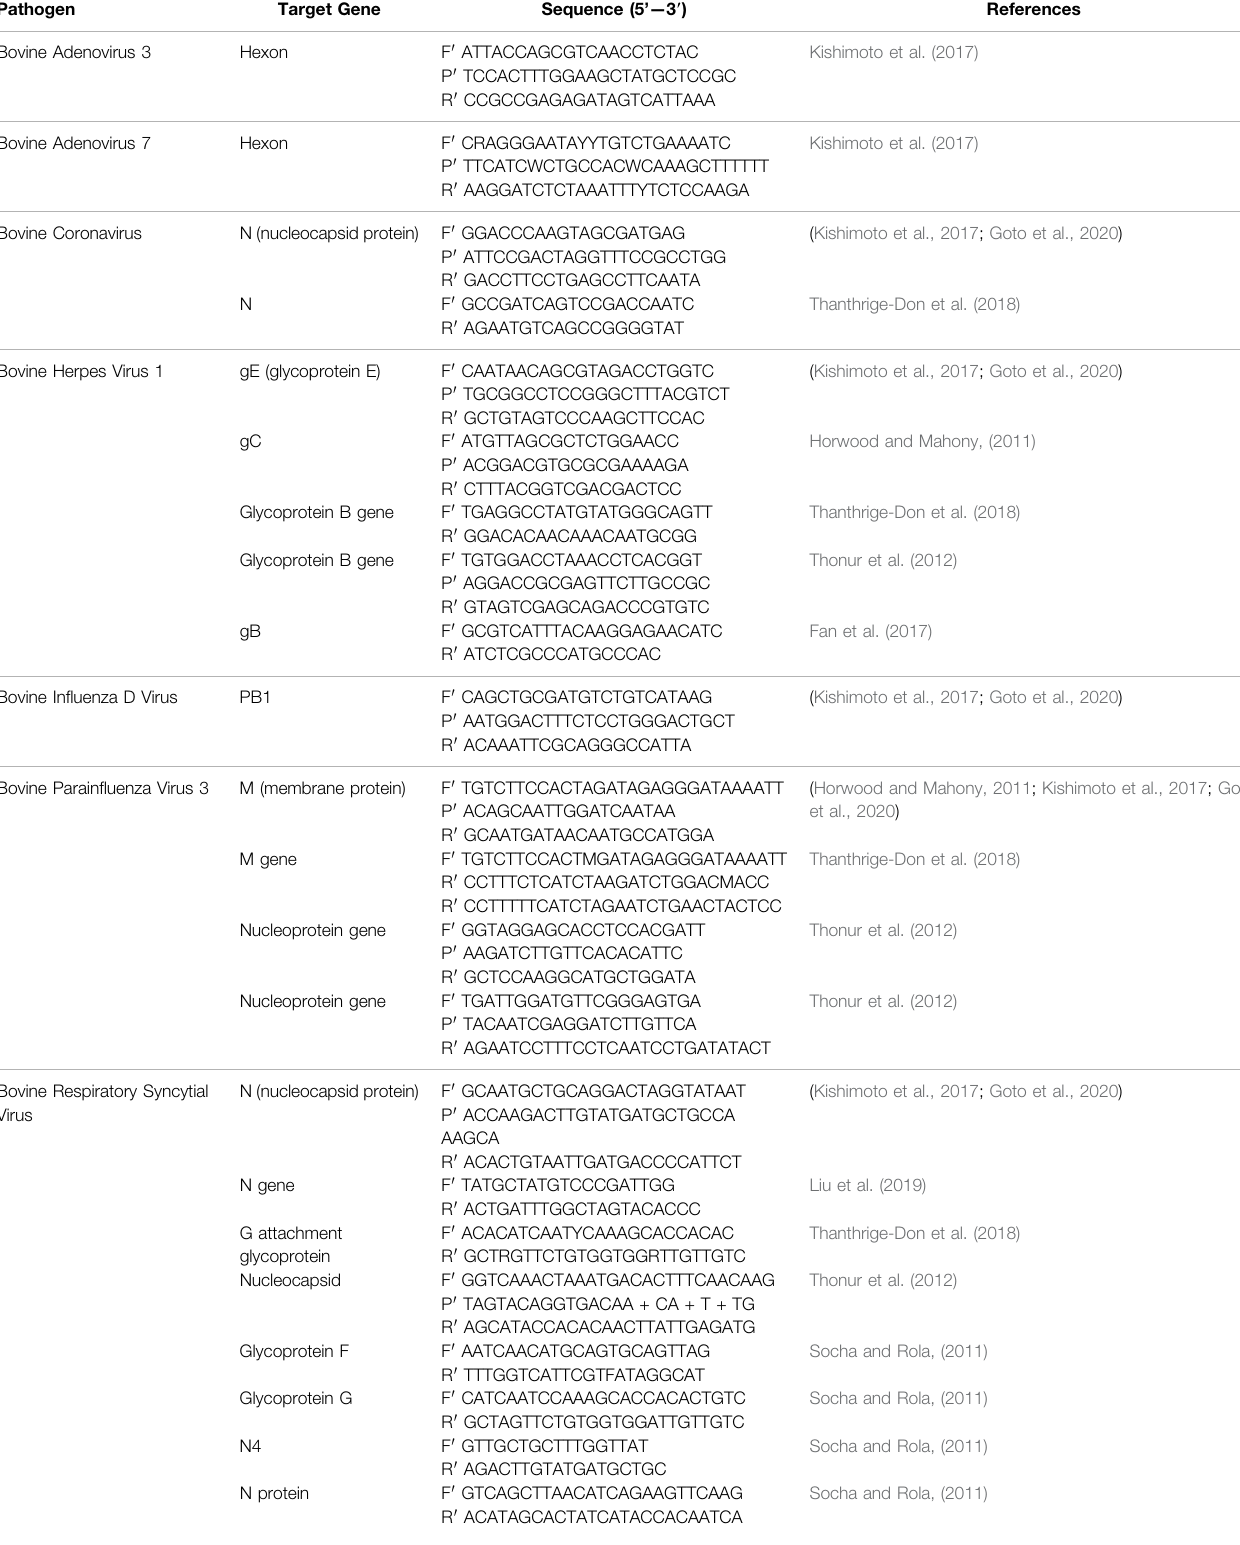
TABLE4| PublishedPCRprimerandprobesequencesfordetectionofviralpathogensassociatedwithbovinerespiratorydiseasecomplex.F ′ forward;P ′ probe,R ’ reverse